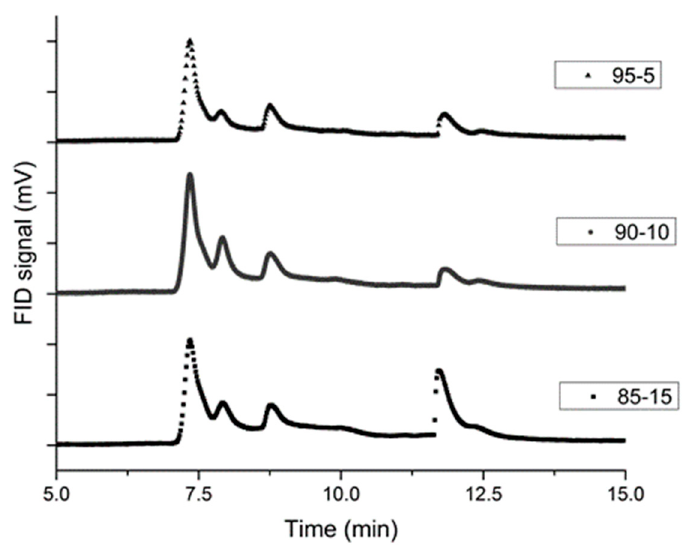
Figure 5. GC chromatographs of the 3 propellants for a probe temperature of 500 °C.